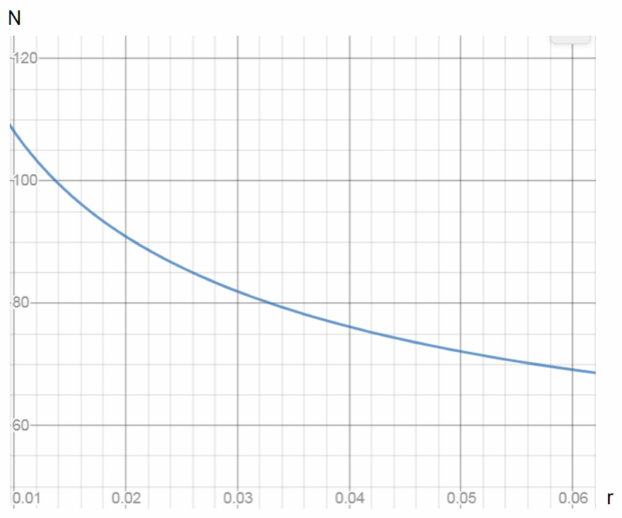
Figure 1. The number of e-folds N as a function of r as given in Equitation